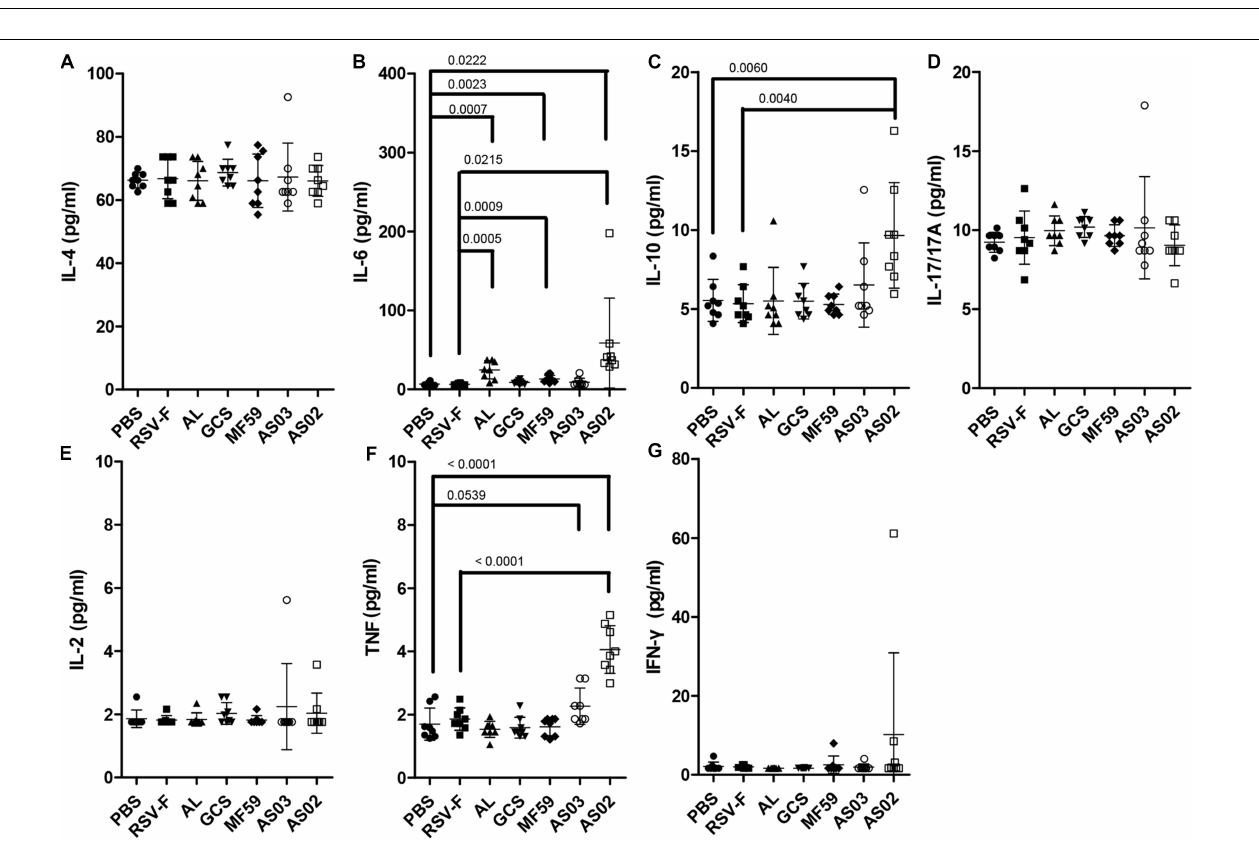
FIGURE 4 | RSV-F-specific IgG1 and IgG2a titers (A) and IgG1/IgG2a ratios (B) in the sera of mice intramuscularly immunized with various adjuvanted vaccines and RSV-F alone at weeks 0 and 2. The sera of six mice in each group were separately detected at 2, 4, 8, and 18 weeks by ELISA. Results are shown as mean ± SD of antibody titers calculated from all six mice in each group.